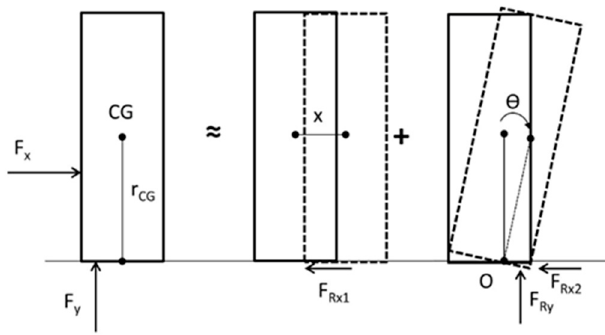
Figure A2. Scheme proposed of the dynamic system. (CG—centre of gravity; r CG — radio of rotation